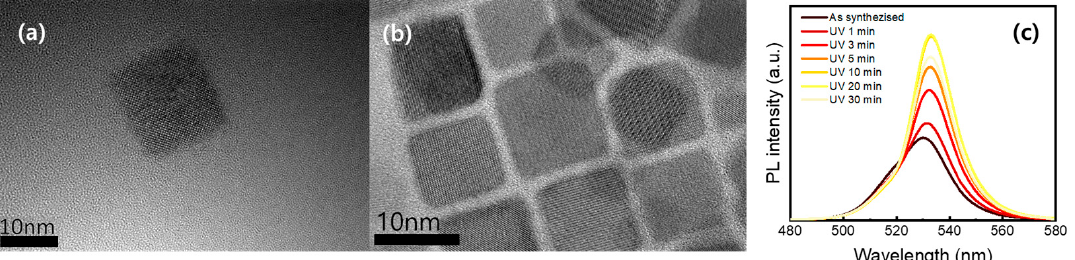
Figure 5. ( a , b ) TEM image of core-shell CsPbBr 3 /SiO 2 NCs ( a ) after 1st cross-linking reaction and ( b ) after 2nd cross-linking reaction. ( c ) PL spectra of film using core-shell CsPbBr 3 /SiO 2 NCs under UV irradiation with different exposure time.